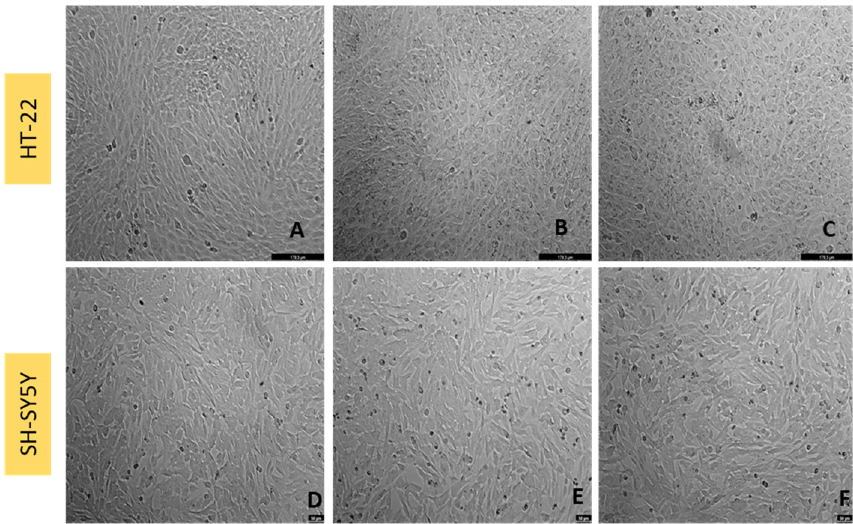
Figure 6. Representative images (100 × total magnification) of HT-22 and SH-SY5Y cells after incubation of H 2 O 2 in combination with mirtazapine. Cells were treated with ( A , D ) vehicle (0.1% DMSO/0.1% sterilized water), ( B ) mirtazapine 0.01 μ M + H 2 O 2 105 μ M, ( C ) mirtazapine 20 μ M + H 2 O 2 105 μ M, ( E ) mirtazapine 0.01 μ M + H 2 O 2 132 μ M, ( F ) mirtazapine 20 μ M + H 2 O 2 132 μ M.